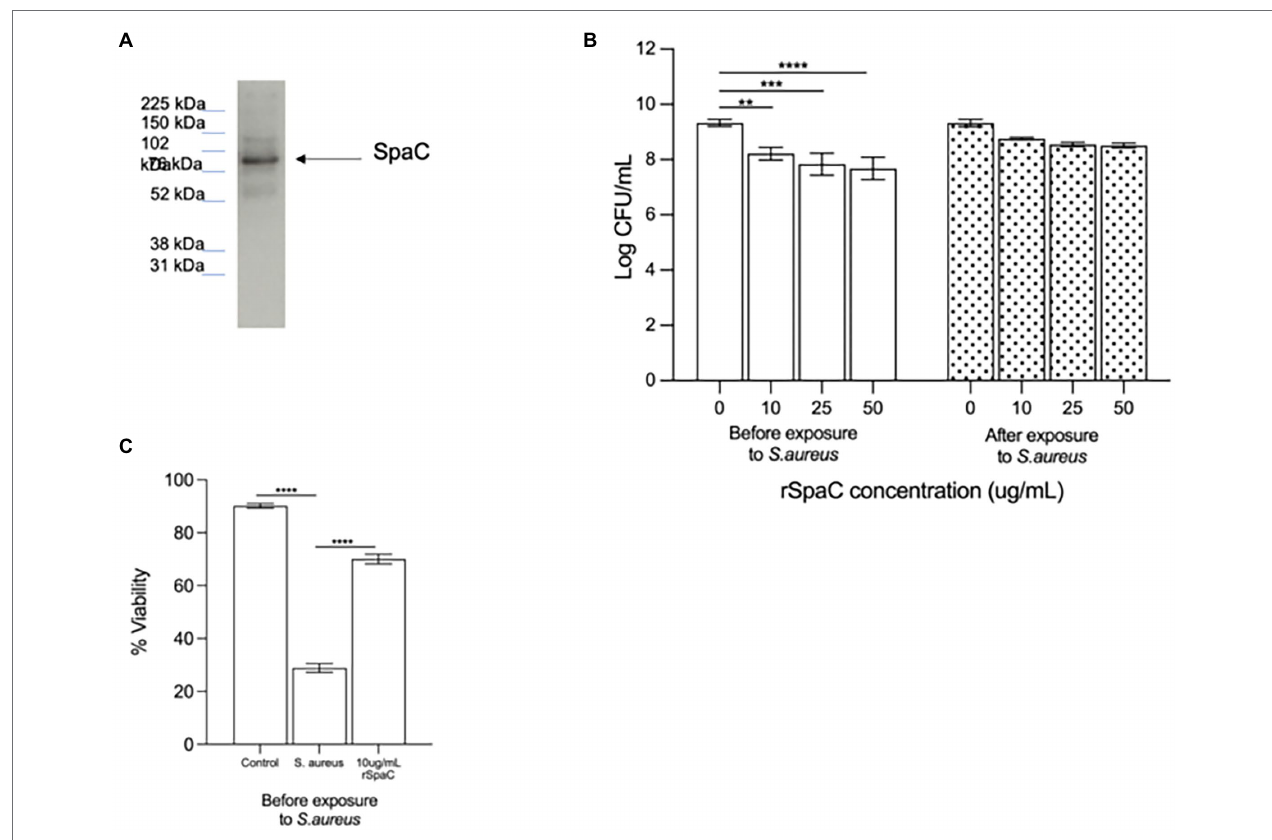
FIGURE 3 | The pilus protein SpaC is involved in the anti-adhesive function of the lysate. (A) Immunoblotting with specific anti-SpaC serum demonstrated the presence of the SpaC protein in the 50% fraction. (B) Addition of recombinant SpaC (rSpaC) prior to addition of the pathogen inhibited staphylococcal adhesion to keratinocytes in a dose-dependent manner (** p = 0.003, ***p = 0.0003, and ****p < 0.0001 for 10, 25, and 50 μ g/mL, respectively, n = 5). However, when added subsequent to exposure of cells to Staphylococcus aureus , rSpaC did not inhibit adhesion ( n = 3). (C) rSpaC at 10 μ g/ml afforded significant protection to keratinocyte monolayer viability in the presence of S. aureus when added prior to the addition of the pathogen ( p = 0.0033). When added subsequent to exposure of cells to S. aureus , rSpaC did not protect keratinocyte viability. Data are presented as the mean ± SEM. ns =